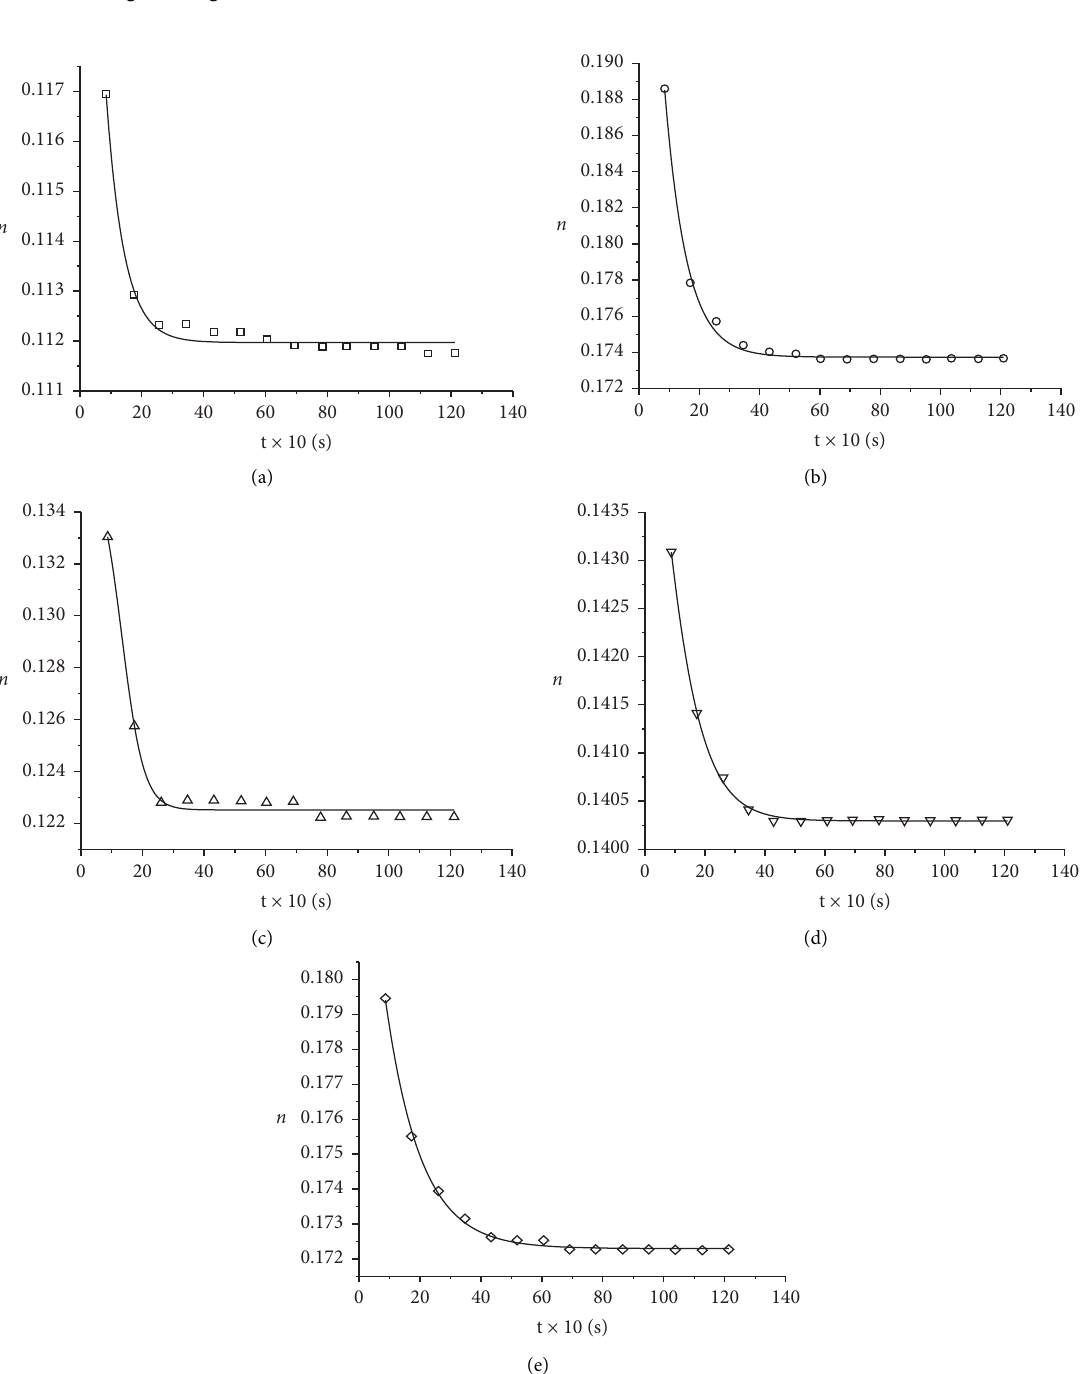
Figure 3: Relation curves between the porosity of fragmentized coals and time under the stress of 12 MPa. (a) m1. (b) m2. (c) m3. (d) m4. (e) m5.